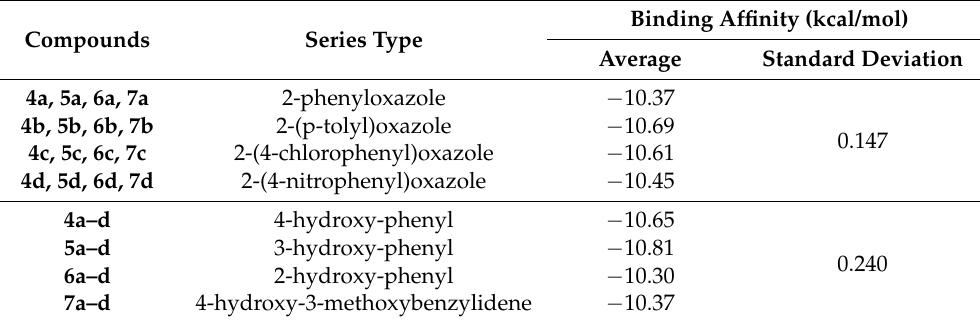
Table 5. Binding affinity average comparison between different structural subseries. Compounds